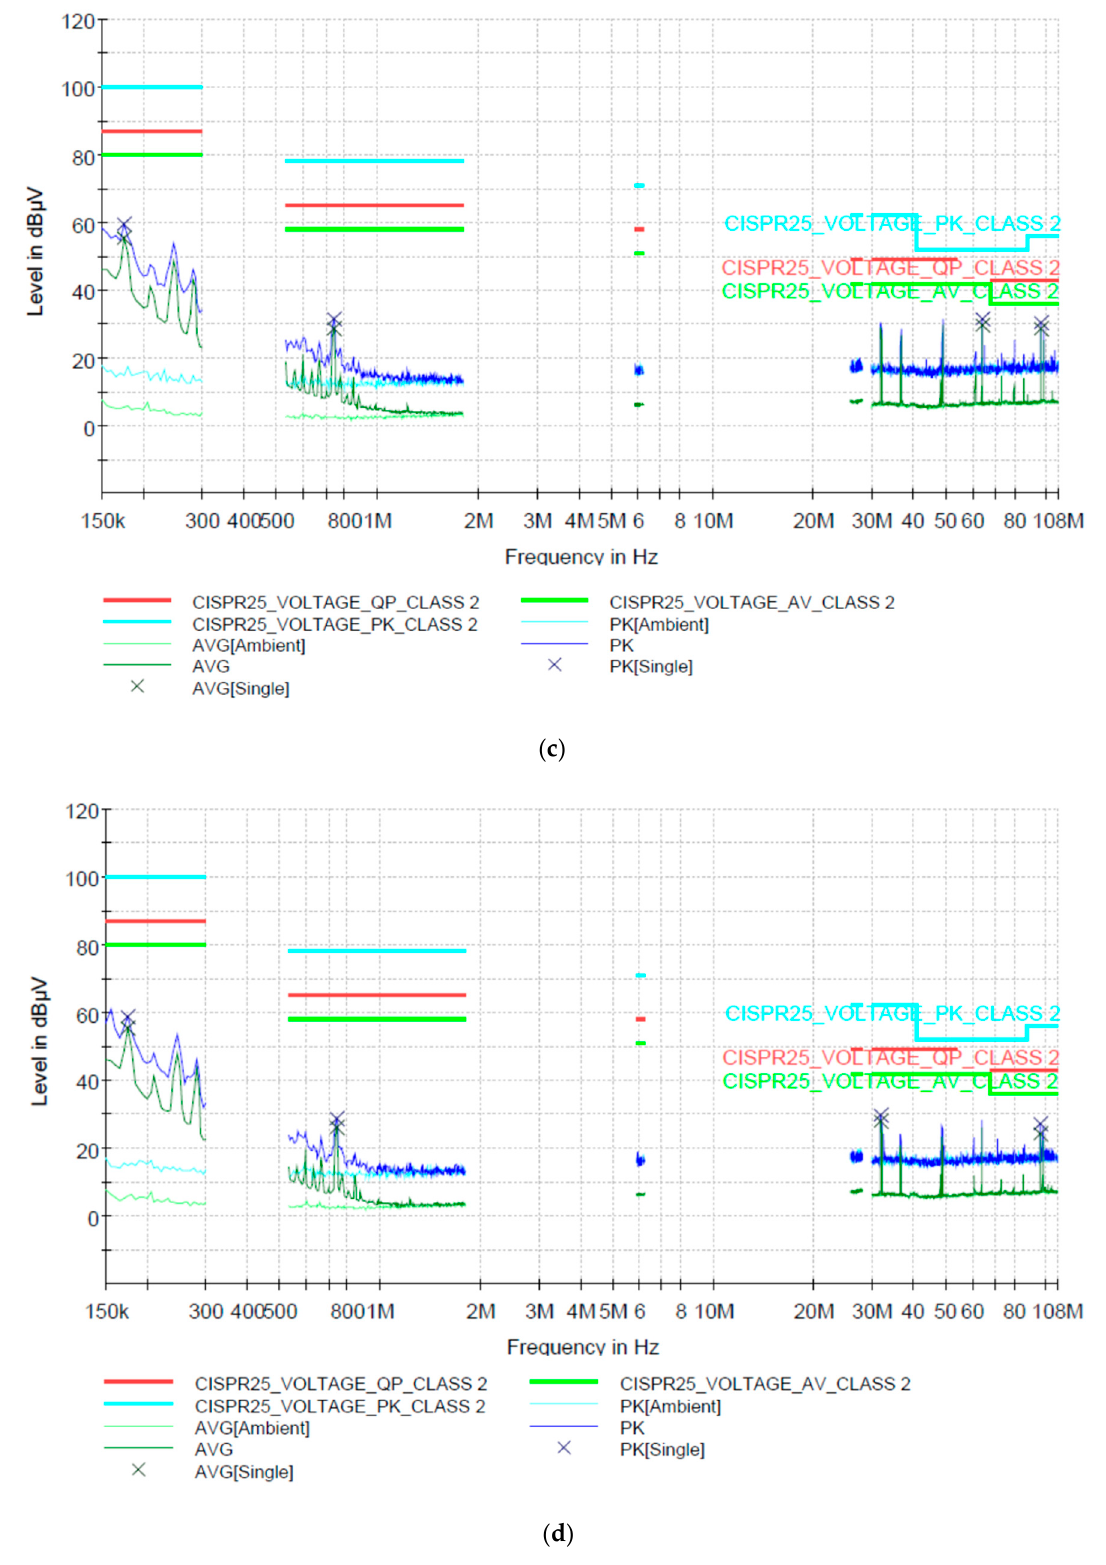
Figure 12. ( a ) EMI experimental environment, ( b ) EMI radiation emission (RE) characteristics of angle module about the horizontal and vertical axes, ( c ) EMI conducted emission (CE) characteristics for the ground line of the module, and ( d ) for the power line of the module.